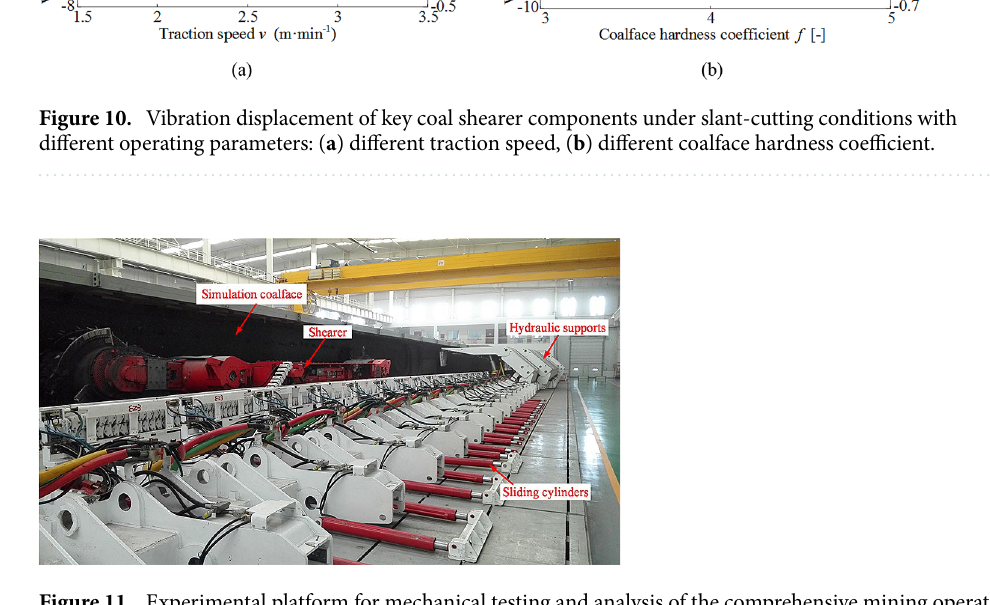
Fig. 11, the experimental platform mainly consists of a 1:1 simulated coal wall, coal shearer, scraper conveyor, hydraulic support, sliding cylinder and data acquisition system, where the coal shearer model is MG500/1130- WD and the scraper conveyor model is SGZ1000/1050. In order to ensure that the data measured in the experiment is realistic and reliable, the simulated coal wall should simulate the geological structure and mechanical properties of the real working face coal seam as far as possible. As the largest supply base of high quality power coal in China, the coal seams in Datong, Shanxi, have better joint development, less impurities, high heat generation and high hardness, and are representative of coal seams in various regions of China, so the coal seams in Datong, Shanxi, are chosen as the simulated object for the experimental coal wall. The simulated coal wall is mainly made of coal, supplemented by raw materials such as cement. The selected coal and cement are mixed by water and an appropriate amount of water reducer is added, and the model coal wall is poured in the form of layer by layer to ensure that the poured simulated coal wall had the characteristics of bedding and jointing, each layer being 300 mm, where the main raw material parameters are shown in Table 5. The simulated coal wall is 70 m long, 4 m wide and 1.5 m high, with a coalface hardness coefficient of f = 3 for the first 35 m and f = 4 for the last 35 m.